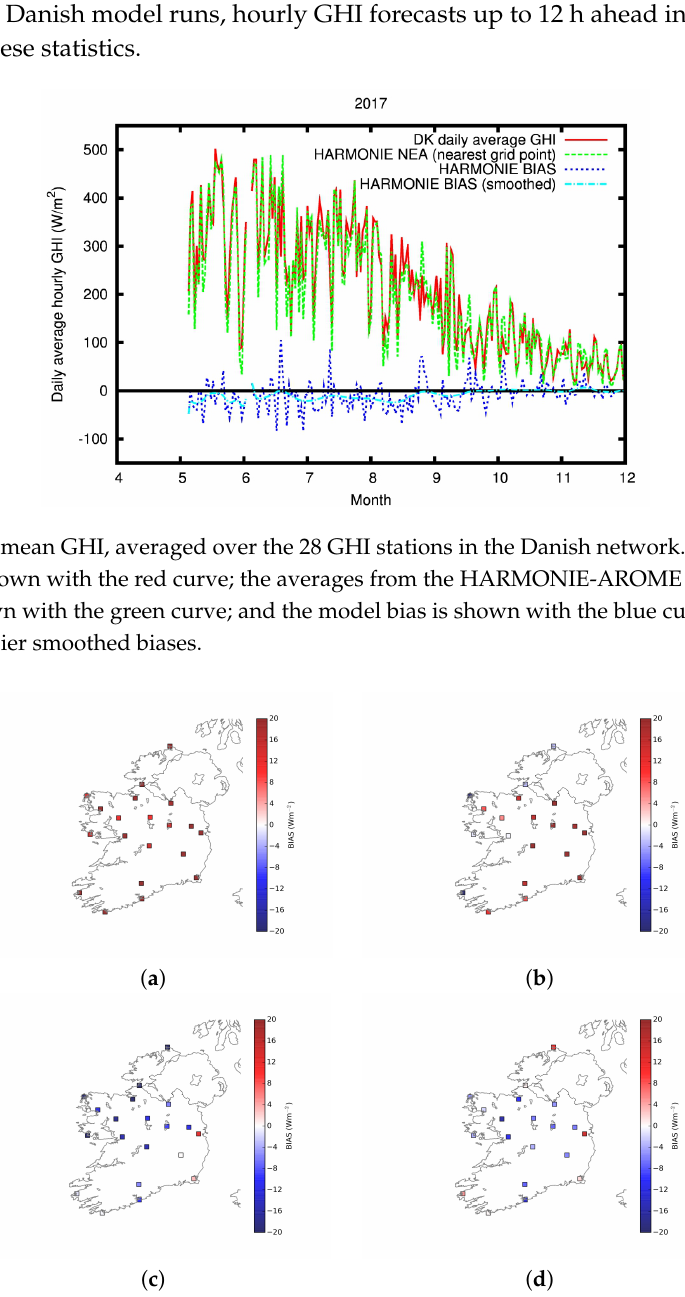
Figure 5. Monthly mean bias (W/m − 2 ) for ( a ) March ( b ) June ( c ) August and ( d ) October using observations and MÉRA data for the period 2008 to